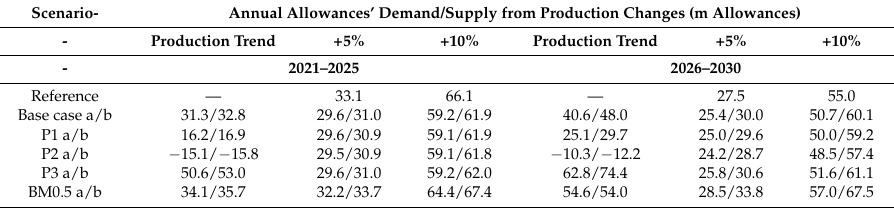
Table 4. Calculated annual allowances’ demand/supply from production